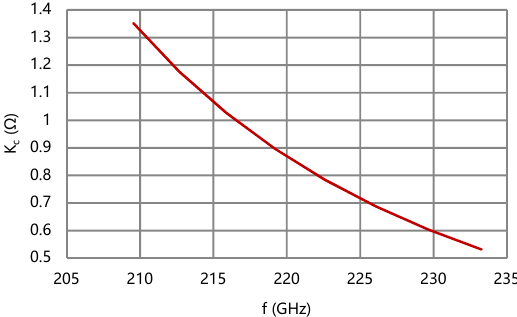
Figure 8. Coupling impedance of the folded waveguide circuit.